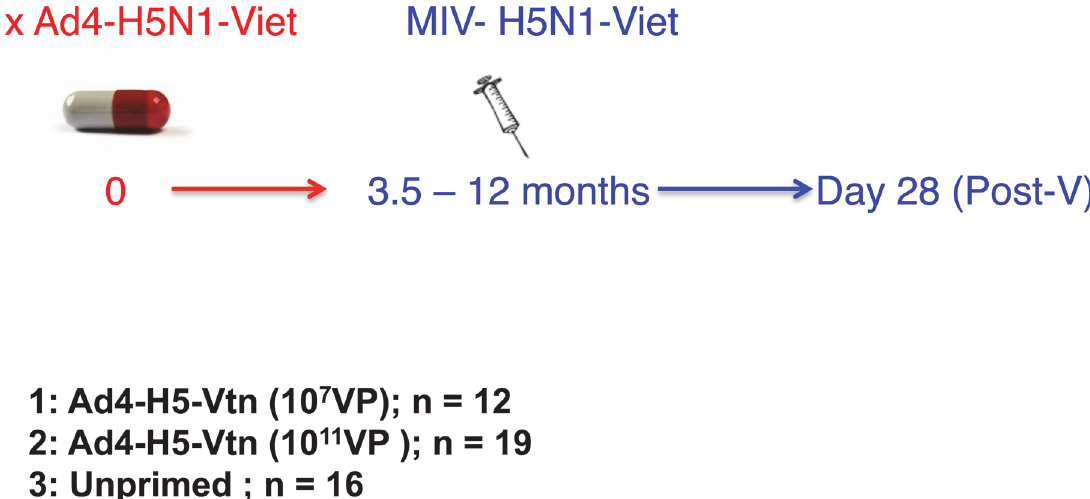
Fig 1. H5N1 prime-boost vaccine trial design. The vaccine study design representing the three groups that were used in the current study and the individual numbers (N) per group is indicated. For more details of the clinical study see Reference 3. Ad4-H5N1-Viet and MIV-H5N1-Viet refer to: Ad4-H5-Vtn is a recombinant, replication competent Ad4, encoding full-length haemagglutinin from influenza A H5N1 virus (A/Vietnam/1194/2004) given orally thrice either as 10 7 virus particles (VP) or 10 11 virus particles per dose. MIV-H5N1-Viet is a formalin-inactivated, licensed inactivated H5N1 partially purified subunit vaccine (A/Vietnam, 90 μ g HA/dose; Sanofi